Question: Identify the chart type used in this figure.
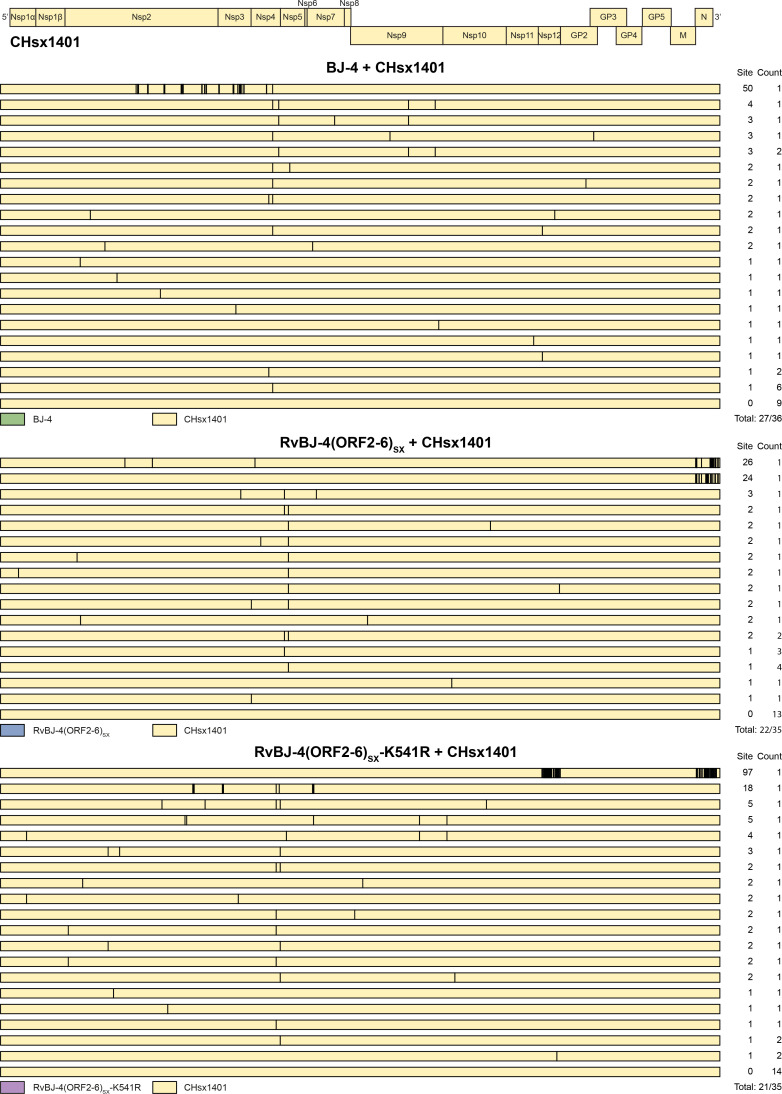
Answer: line